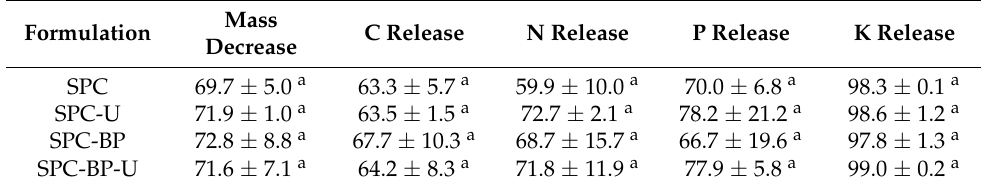
Table 8. Percentage of release in solution of total C and nutrients after 25 days experiment, and pellets mass decrease, relative to the initial values in the formulation 1